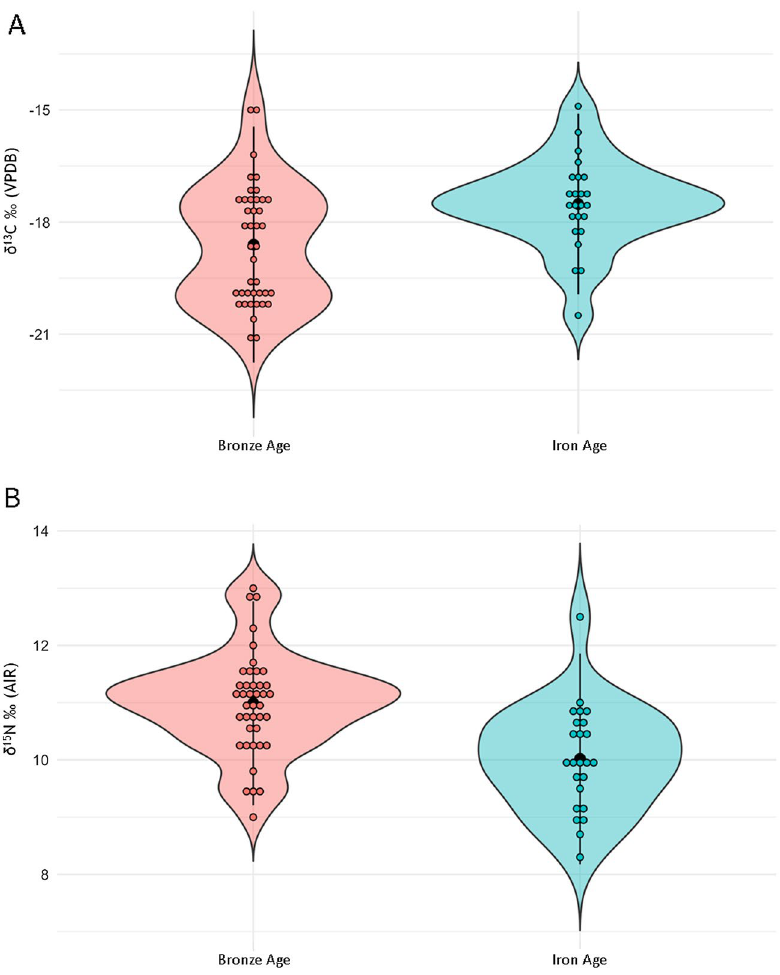
Figure 3. Violin plot of human ( A ) δ 13 C and ( B ) δ 15 N ratios by period: Bronze Age (n = 50) and Iron Age (n = 24). Center black dot represents mean; center black line represents